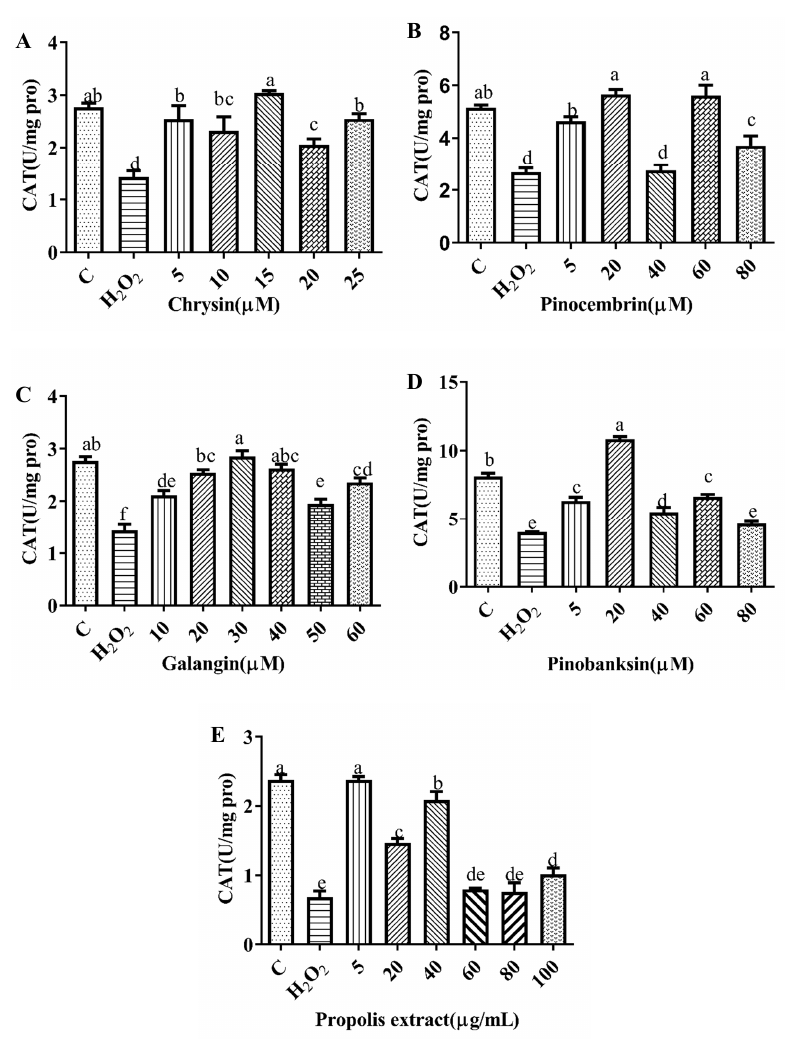
Figure 5. CAT levels induced by individual flavonoids (chrysin, pinocembrin, galangin, and pinobanksin) and propolis extract in 150 µ M H 2 O 2 -induced H9c2 cells. H9c2 cells were stimulated with different concentrations of phytochemicals (chrysin, pinocembrin, galangin, and pinobanksin) and propolis extract for 12 h and then treated with 150 μ M H 2 O 2 for 1 h; finally, CAT levels were detected using Catalase Assay Kit. ( A ) CAT levels in chrysin-induced H9c2 cells. ( B ) CAT levels in pinocembrin-induced H9c2 cells. ( C ) CAT levels in galangin-induced H9c2 cells. ( D ) CAT levels in pinobanksin-induced H9c2 cells. ( E ) CAT levels in propolis-extract-induced H9c2 cells. Values are expressed as the mean ± SEM ( n = 4). Values with different letters (a, b, c, d, e) in the figure showed significant differences at p <